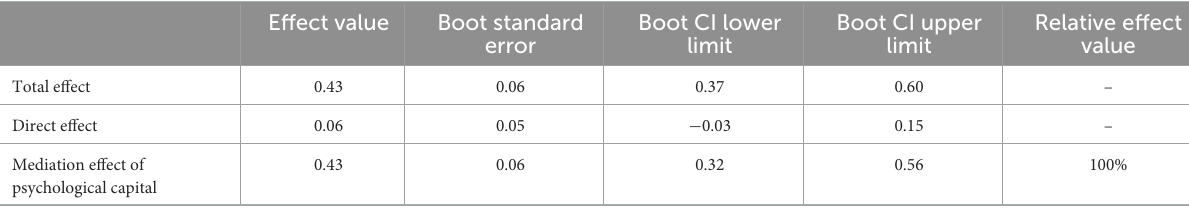
TABLE 2C Mediation analysis.